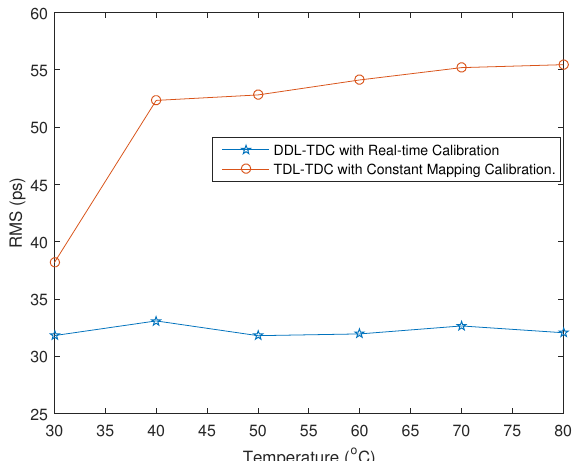
Figure 11. RMS values obtained at various temperatures with 7-bit digital